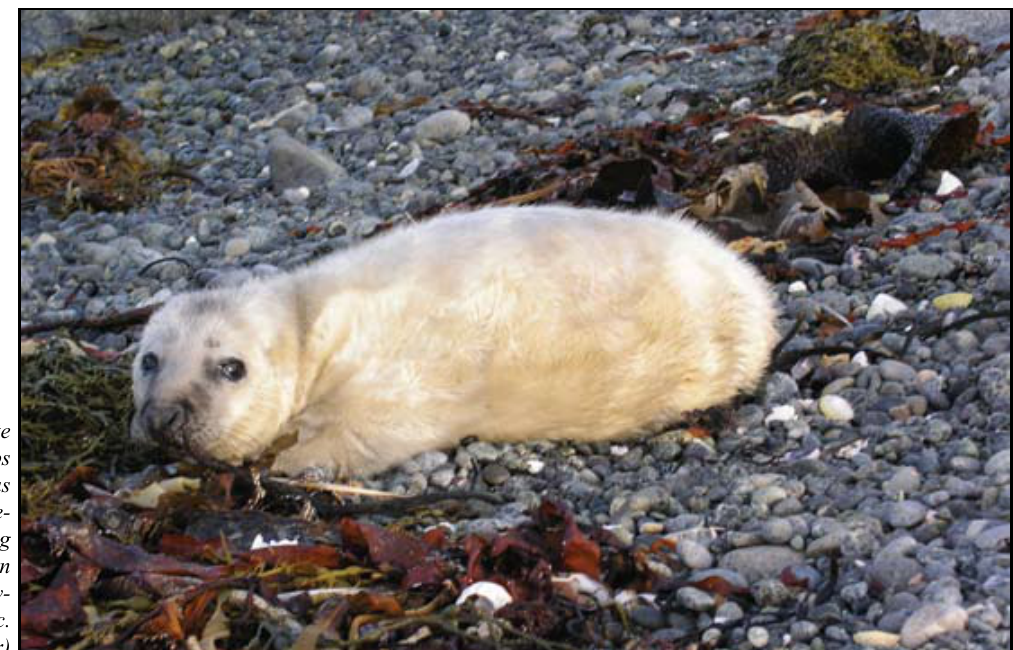
Fig. 2. The white coat of grey seal pups suggests an origin as an ice-breeding spe - cies, and ice-breeding remains common in the Gulf of St Law - rence and the Baltic. (Photo: Sonja